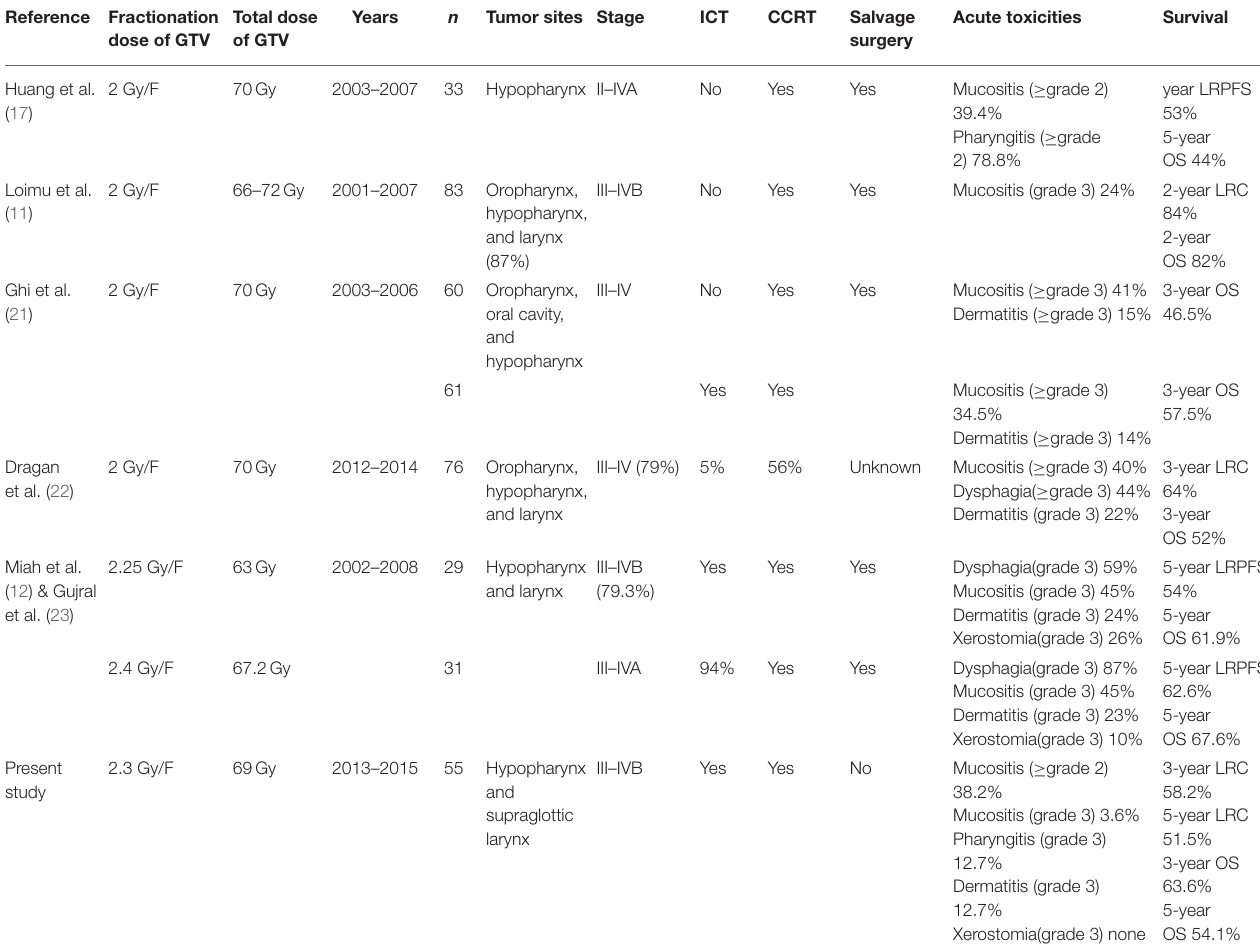
TABLE 3 | Selected literature review on fractionation regimens. Reference Fractionation Total dose Years n Tumor sites Stage ICT CCRT Salvage dose of GTV of GTV